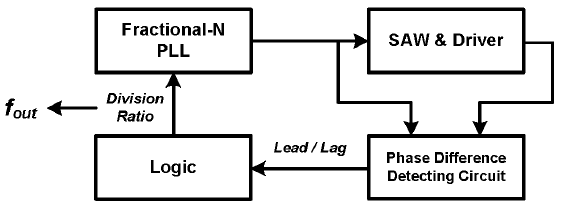
Figure 3. Block diagram of the proposed architecture, including the SAW under test and its driver circuit, the fractional-N PLL as test stimulus, the phase difference detecting circuit and the control logic for working flow control.